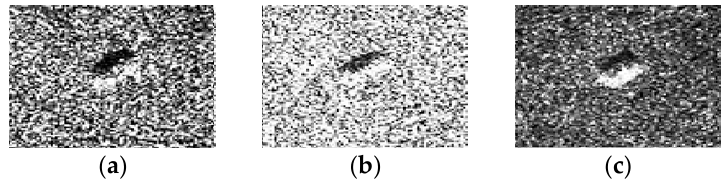
Figure 21. The microwave images of three targets in large depression angle experiments. ( a ) BRDM2; ( b ) 2S1; ( c ) ZSU234.